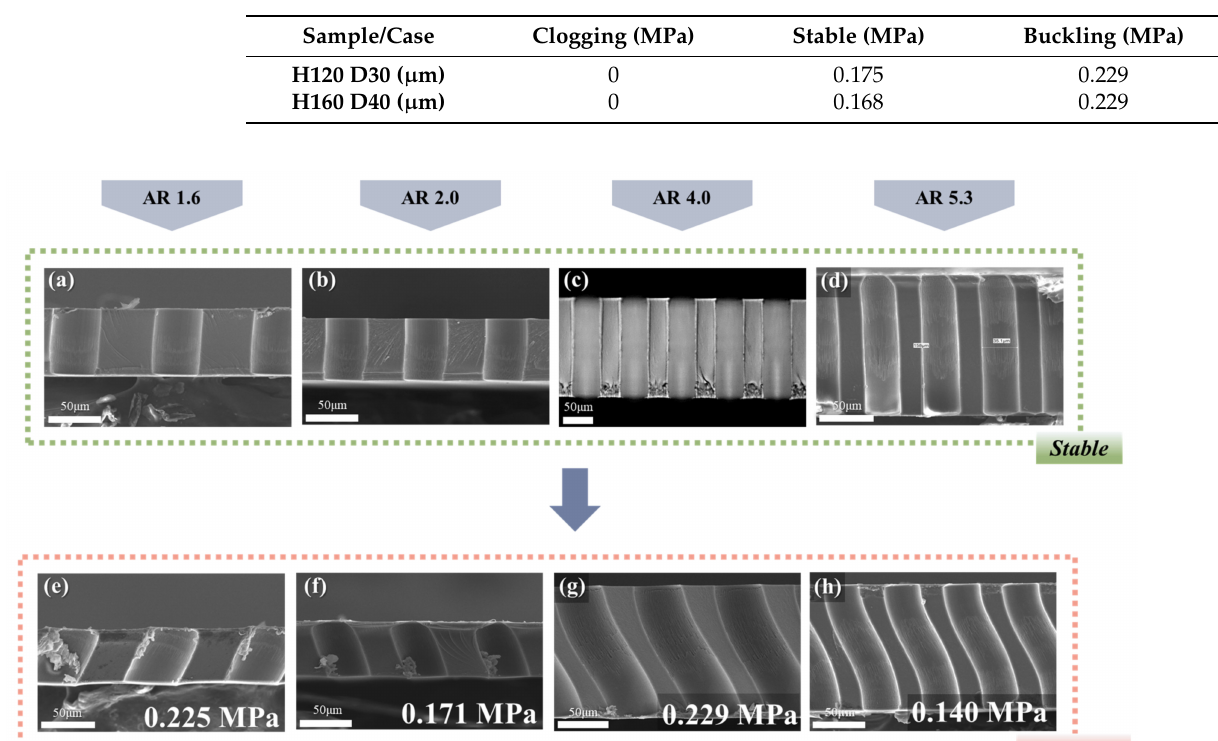
Figure 4. ( a , b ) SEM and OM images of constructed polymeric stencil membranes with aspect ratio of 4 and imprint pressure variation. Structural geometry with a diameter of 30 µ m and a height of 120 µ m ( a ), and a diameter of 40 µ m and a height of 160 µ m ( b ). Table 2. Applied imprint pressure during fabrication of polymeric stencil membranes with aspect ratio of 4.